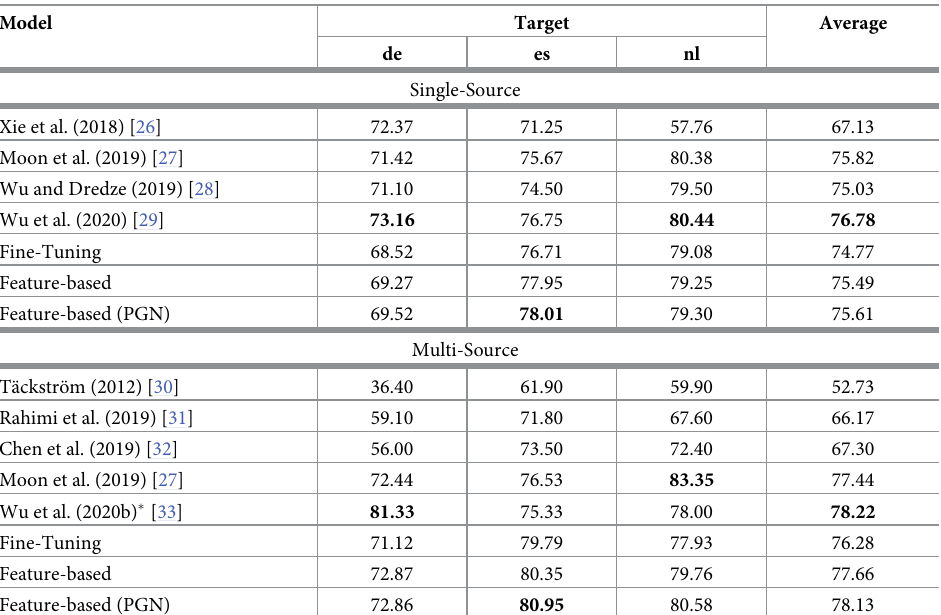
Table 4. Comparisons with previous